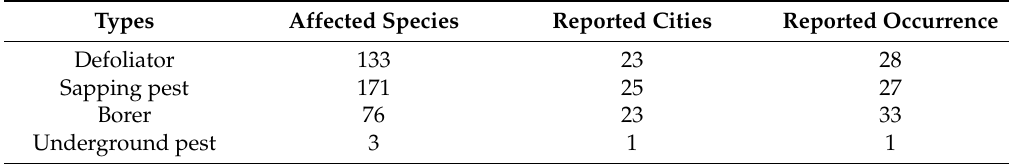
Table 6. Summary of impacts caused by pests on urban trees in China.